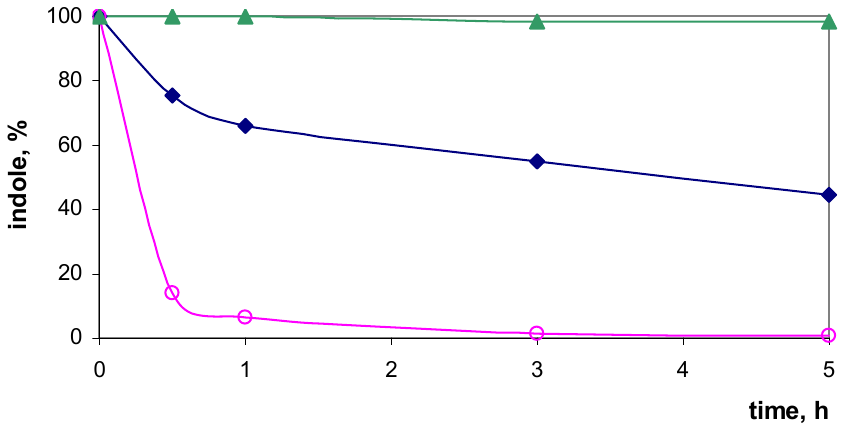
Fig. 5 Alkylation of indole potassium salt with different alkylating reagents (in [bmim] [Br] at 25 ◦ C with: a) (cid:2) – benzyl chloride; b) (cid:3) – 1- chlorobutane; c) ◦ –